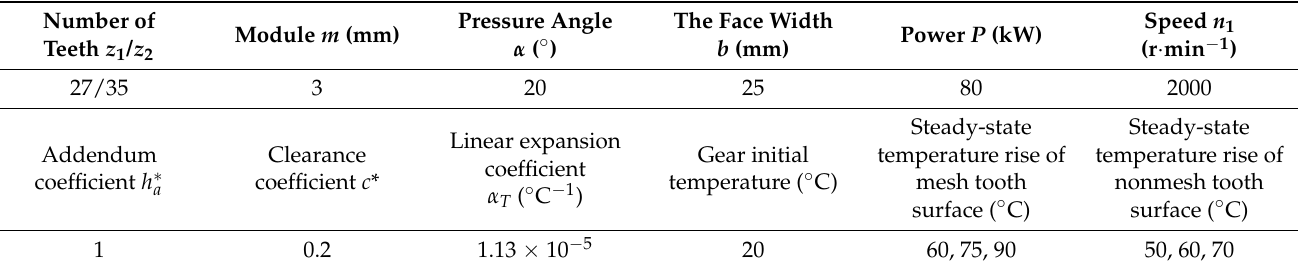
Table 2. Parameters of the spur gear pair.